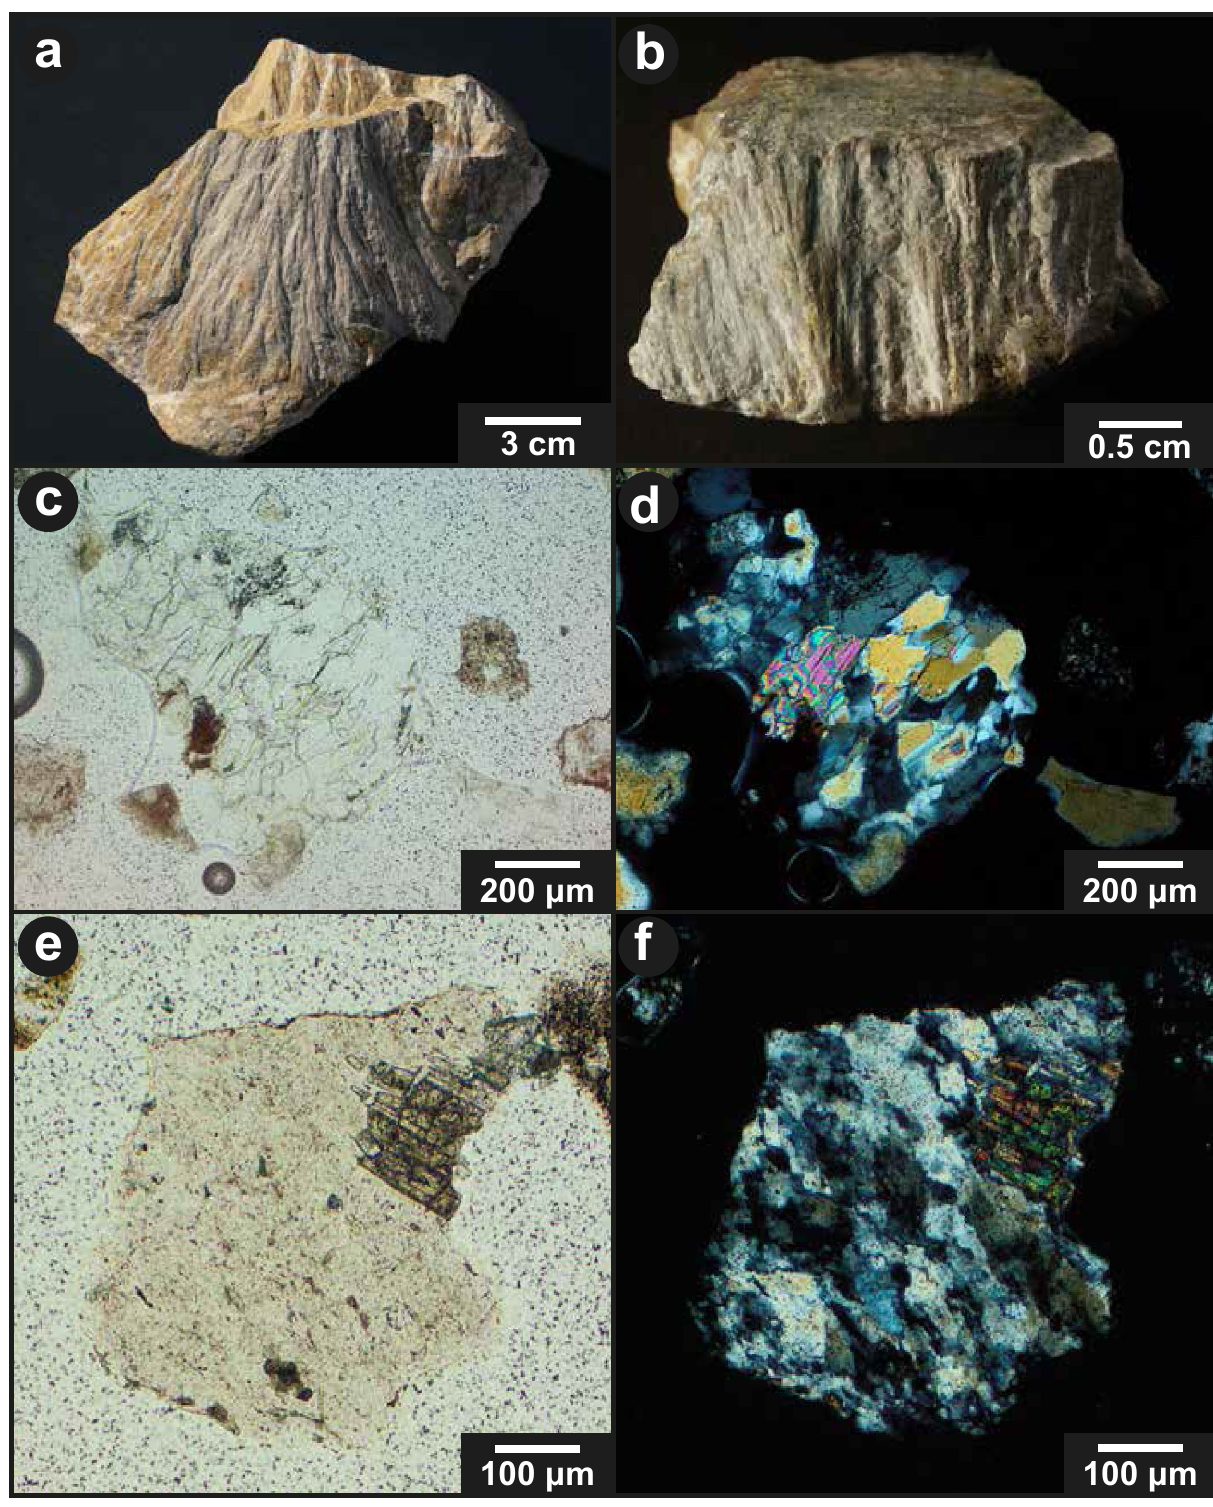
Figure 4. Clasts from the Blockhorizont at Bernhardzell (i.e., our sampling locality of the Blockhorizont). ( a , b ) Limestone fragments with shatter cones (Natural History Museum Bern collection; Photographs taken by Peter Vollenweider, Natural History Museum Bern). ( c ) Rock fragment with quartz, muscovite, and a mafic phase (plane-polarized light; PPL). ( d ) Fragment from ( c ), in cross-polarized light (XPL). ( e ) Rock fragment with quartz and titanite (PPL). ( f ) Fragment from ( e ), in